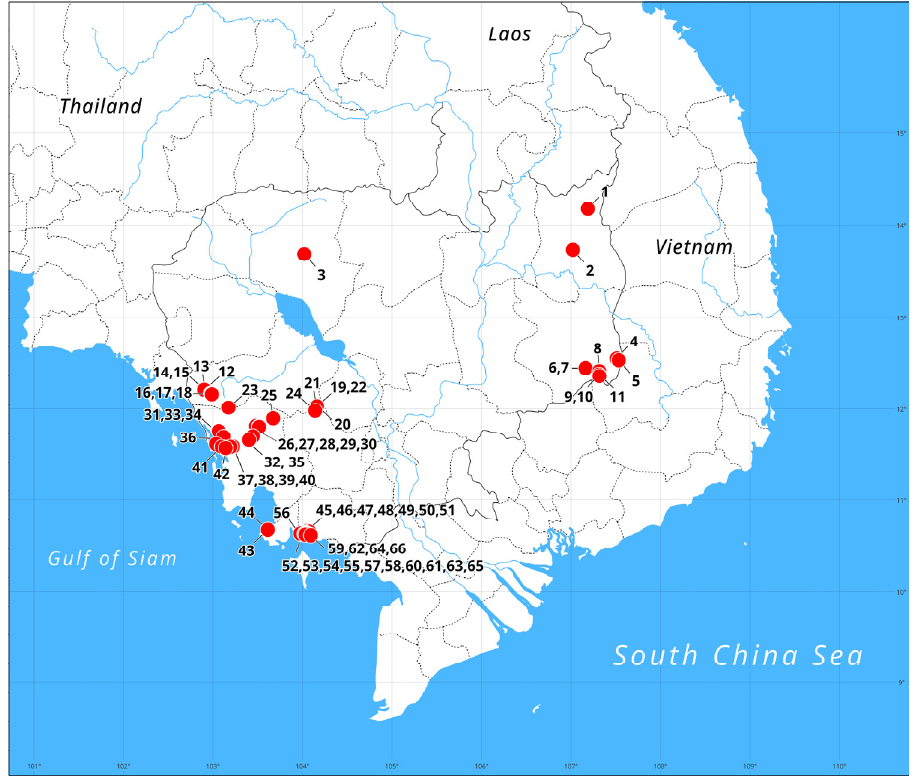
Figure 1. Collecting sites in Cambodia (in accordance to the Table 2, Table 3 and the checklist).